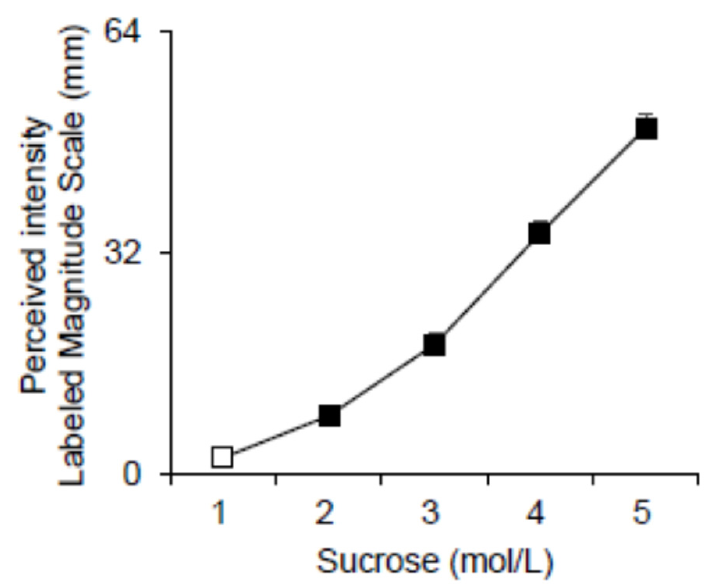
The sweet intensity ratings evoked after stimulation with the five suprathreshold sucrose solutions are shown in Figure 1. Repeated measures of ANOVA revealed that the perceived intensity rating significantly increased as a function of the increase in con- centration (F (4, 428) = 315.71, p = 0.0000) (Figure 1). Post hoc comparison showed that the perceived intensity ratings for all concentrations were higher concerning those evoked by the preceding concentrations ( p ≤ 0.00012; Fisher LDS).